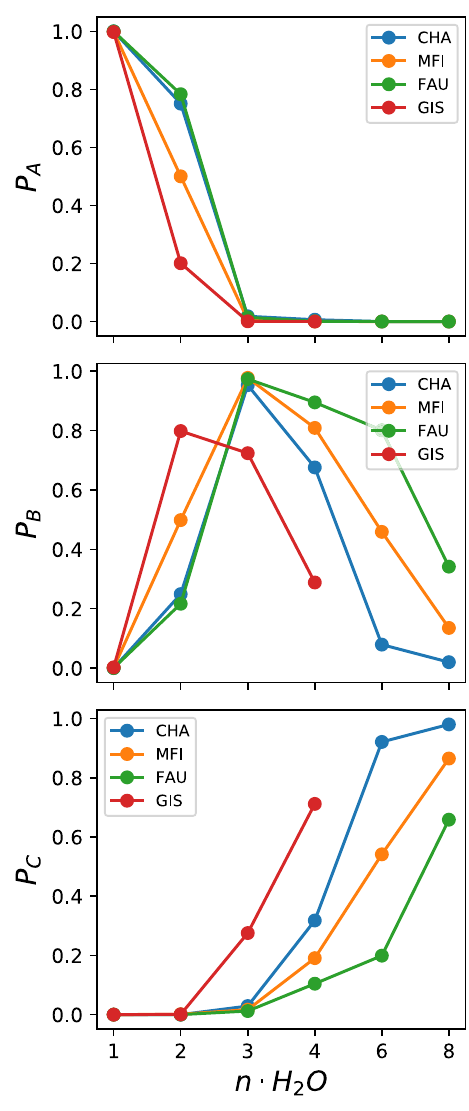
Fig. 5 Relative populations as a function of water loading. Relative population of the state A (top panel), B (middle panel) and C (bottom panel) as a function of the water content for every zeolite.